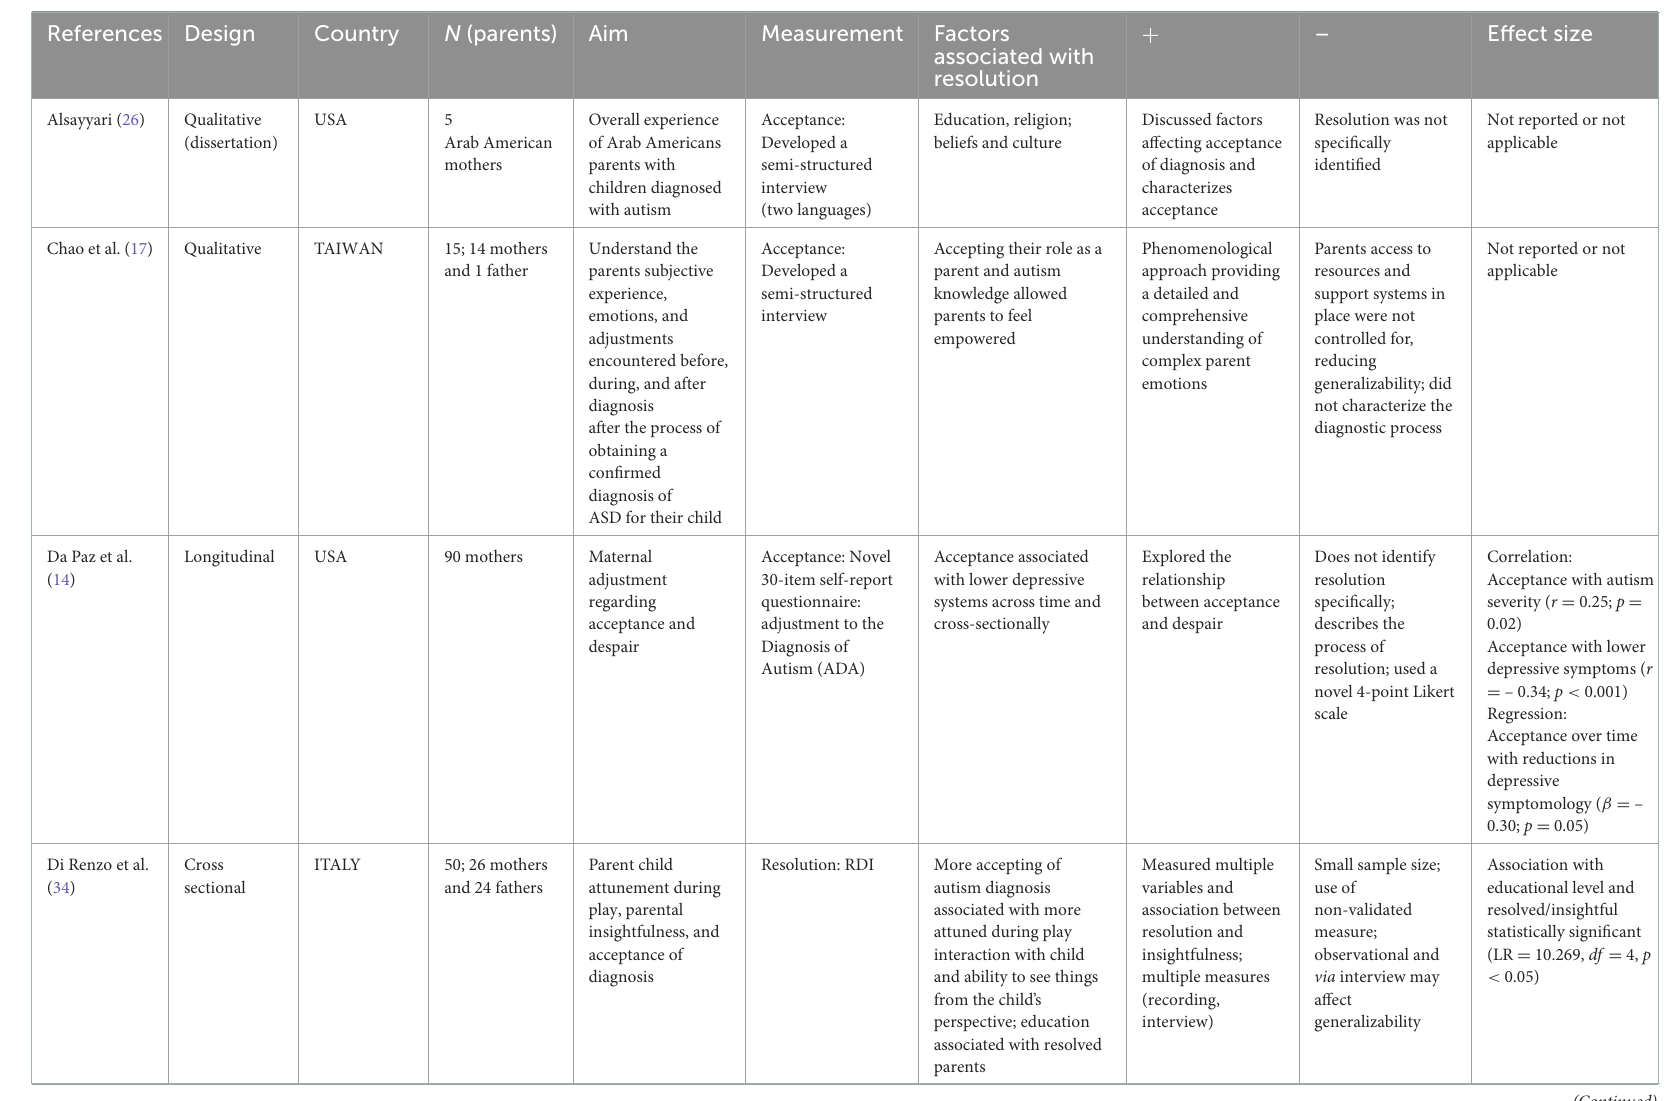
TABLE 3 Summary of reviewed